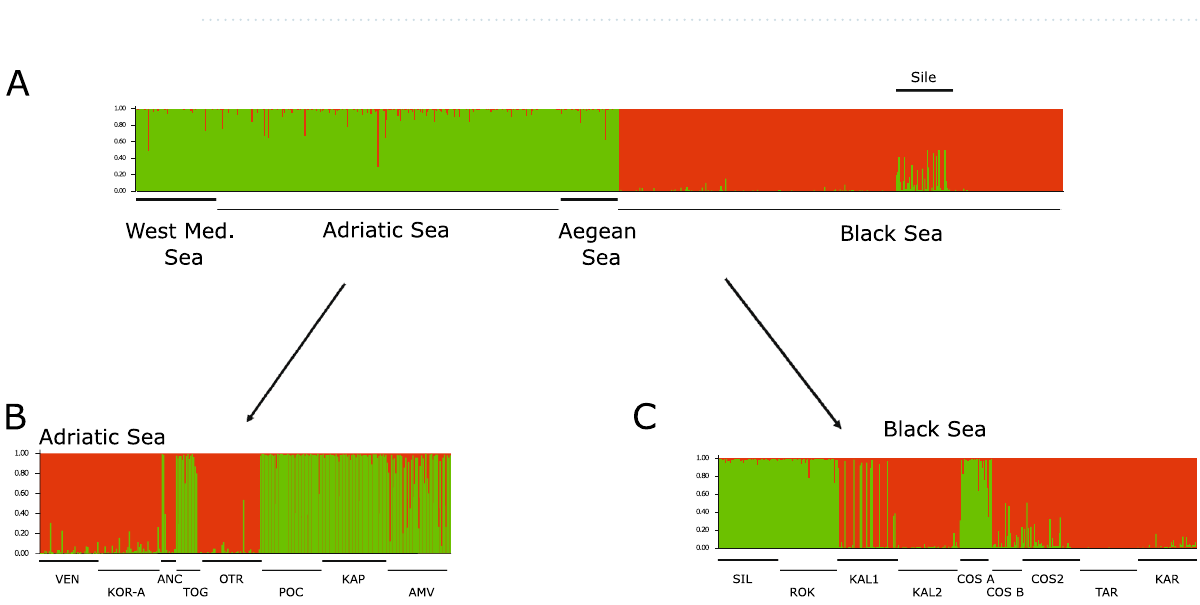
Figure 4. Principal Coordinates Analysis (PCoA) of the 17 localities sampled for Tritia neritea genotyped at 11 microsatellite markers. Coordinate 1 explains 40% of the variation while coordinate 2 explains 15% of the variation.